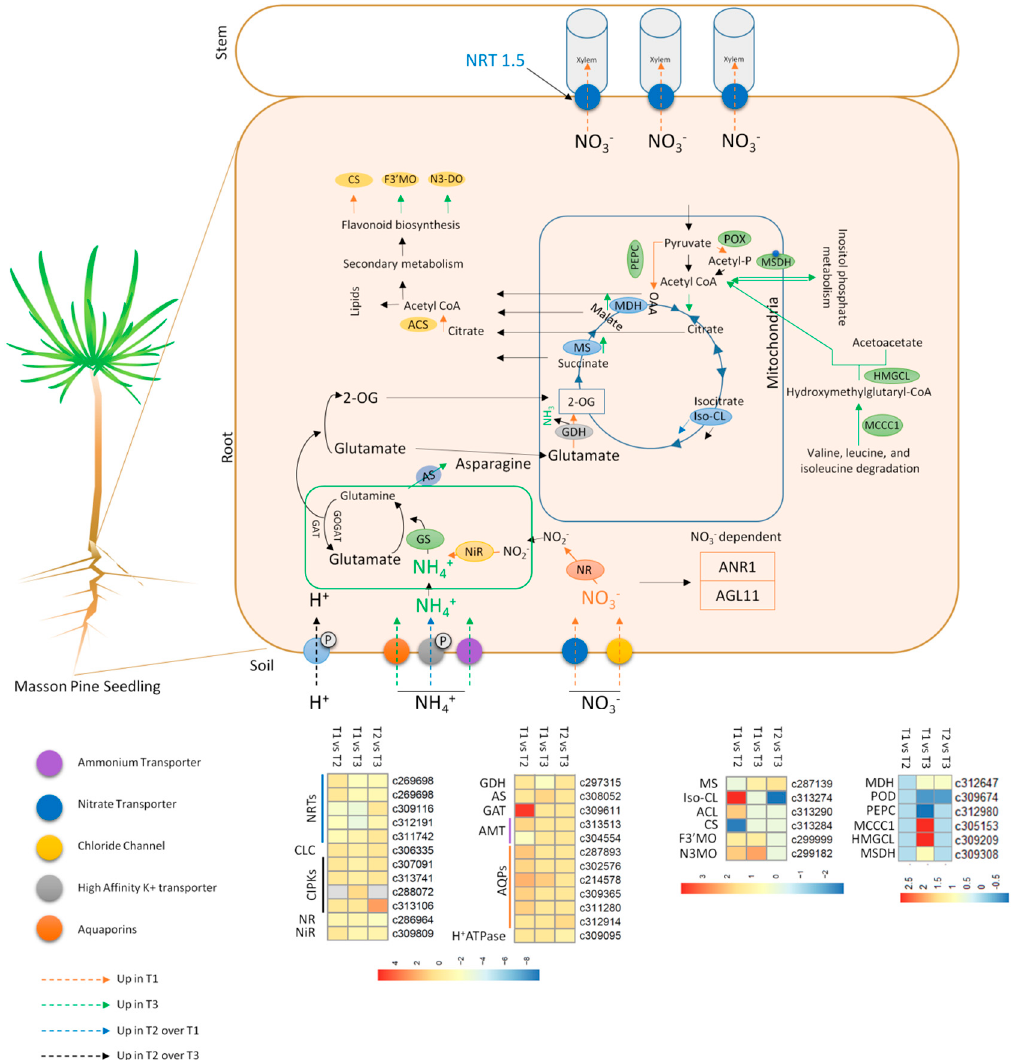
Figure 7. Schematic representation of key transcriptional changes in masson pine seedlings grown in nitrate (T1), mix of nitrate and ammonium (T2), and ammonium (T3). Green and blue boxes represent chloroplast and mitochondria, respectively. The colors of arrows represent their respective regulation by either of the treatment. NRTs (nitrate transporters), AMTs (ammonium transporters), CLC (chloride channel), CIPK (CBL-interacting protein kinase), NR (nitrate reductase), NiR (nitrite reductase), GS (glutamine synthetase), GOGAT (glutamate synthase), AS (asparagine synthetase), GDH (glutamate dehydrogenase), 2-OG (2-oxoglutarate), MS (malate synthase), MDH (malate dehydrogenase) OAA (oxaloacetate), Iso-CL (isocitrate lyase), AQP (aquaporins), ACL (ATP citrate lyase), CS (citrate synthase), F3’MO (flavonoid 3’- monooxygenase), N3DO (naringenin 3- dioxygenase), PEPC (phosphoenolpyruvate carboxylase), POX (pyruvate oxidase), MSDH (malonate- semialdehyde dehydrogenase), HMGL (methylmalonate-semialdehyde dehydrogenase), MCCC1 (3- methylcrotonyl-CoA carboxylase alpha subunit). The heatmaps show the log2 foldchange values (in three treatment comparisons) of differentially expressed genes in P. massoniana roots.